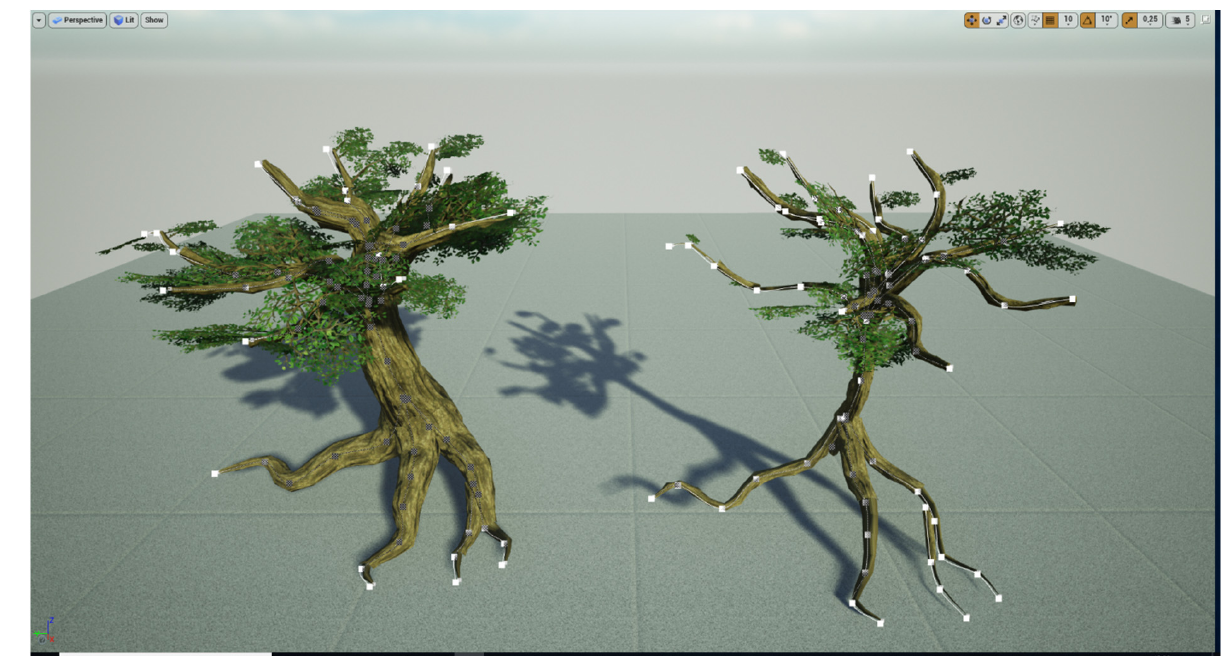
ISPRS Int. J. Geo-Inf. 2021 , 10 , 518 Figure 3. Example of an individual representation of trees with different properties as 3D objects (in Unreal Engine 4; own illustration by Dennis Edler and Timo Wiedenlübbert).